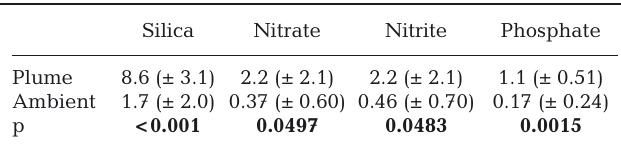
Table 2. Results of t -test comparing surface nutrient concentrations (µmol l −1 , mean ± SD) between the discharge water (Stn P1) and water 1.4 km from the outfall (Stn P7, see Fig. 1 for station loca- tions). Significant differences between plume and ambient water